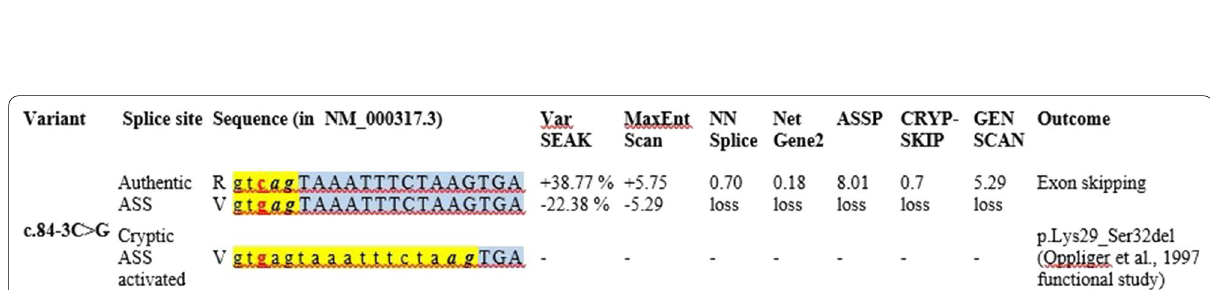
Fig. 2 In silico analysis of PTS :c.84-3C>G variant using splicing predictive tools. Although exon skipping was predicted by these tools, according to Oppliger et al. (1997) functional study, the use of a cryptic splicing site would result in a deletion of 12 nucleotides at the beginning of exon 2 and finally, a deletion of four amino acids